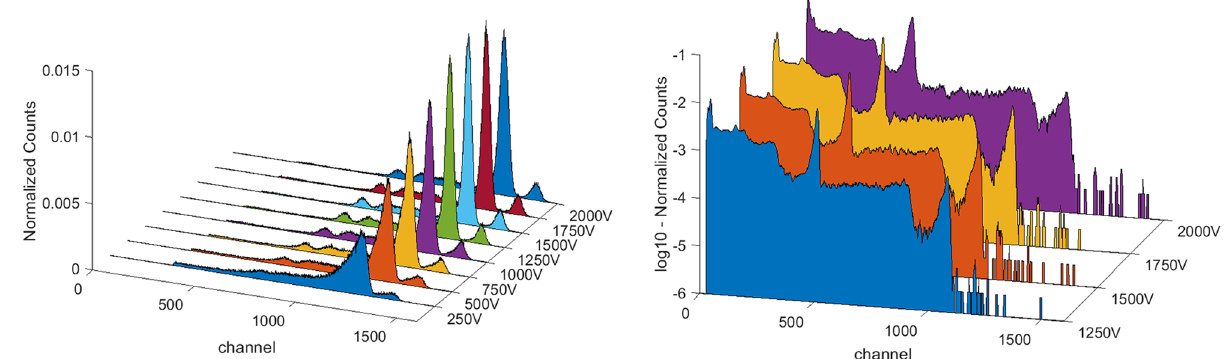
Figure 6. Co-57 (left) and Na-22 (right) spectra acquired with detector V5 750A at different bias voltages. Measurements were carried out at 20 °C.